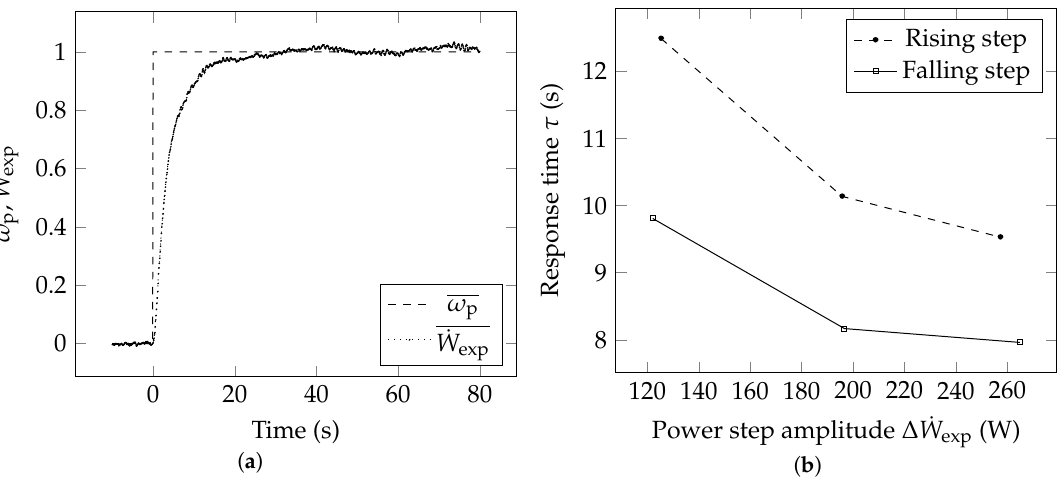
Figure 8. ( a ) Dynamic response of the ORC system to a step in pump veloctiy from 1100 to 2000 RPM at fixed heat-source temperature ( T hs = 120 ◦ C) and expander load ( R exp = 25 Ω ). ( b ) Rising and falling step-response times as functions of the step amplitude in expander